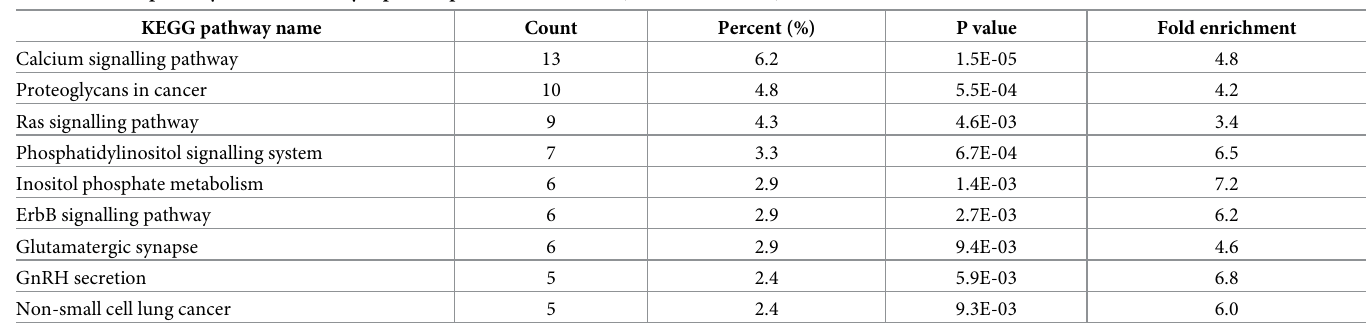
Table 1. KEGG pathways of differentially expressed proteins in rat testis (METH vs. control). KEGG pathway